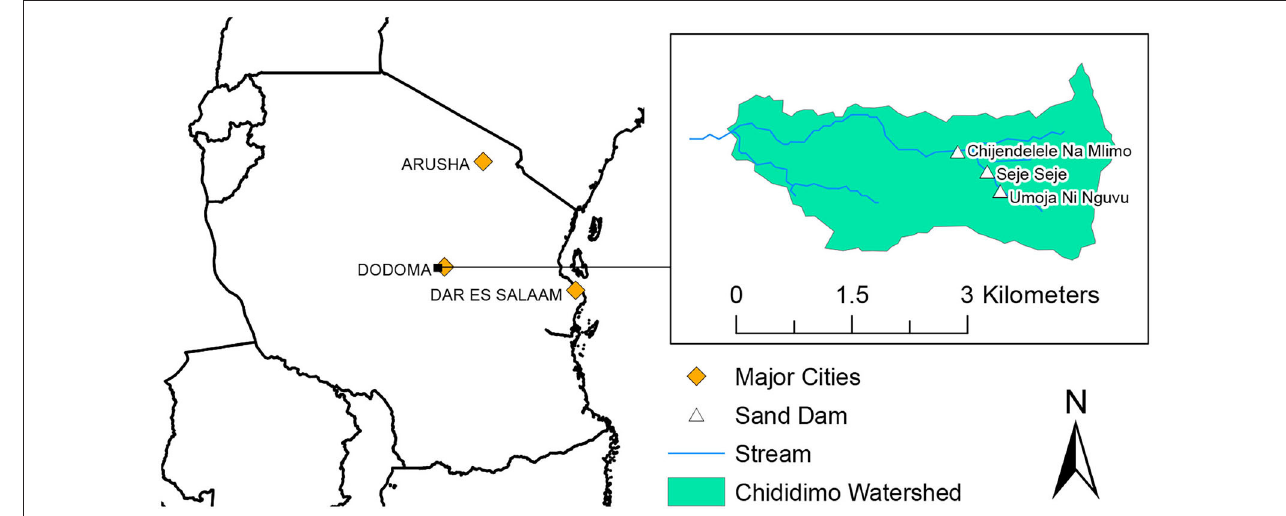
FIGURE 2 | Chididimo watershed near Dodoma, Tanzania with three cascading sand